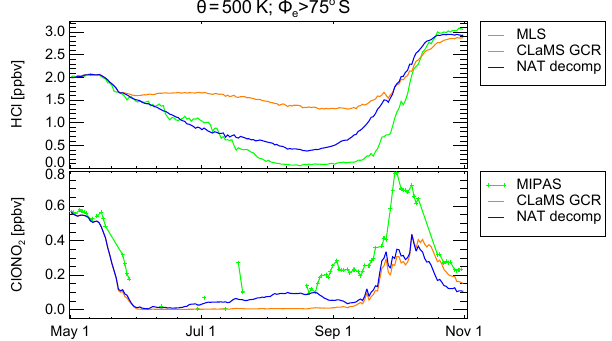
Figure 11. Average mixing ratios in the vortex core ( (cid:56) e > 75 ◦ S, θ = 500K) of HCl (a) and ClONO 2 (b) . Green lines show MLS and MIPAS observations, respectively. The red line shows the CLaMS simulation including GCR-induced ionisation. The blue and pink lines correspond to simulations with additional photolysis of partic- ulate HNO 3 using the lower and upper estimates, respectively, as described in the text.